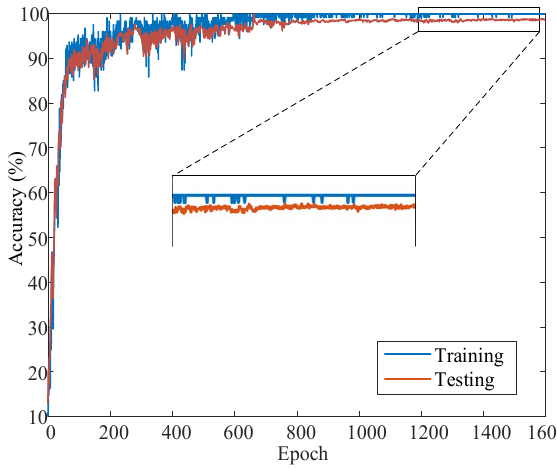
Figure 9. BayesianPDL framework training process. When PFRBs is 3, the uncertainty distribution of the network is shown in Figure 10. The probability density of the uncertainty distribution proposed method is significantly reduced due to the heavily disturbed noise on the signal at low SNR. This reduces the confidence of the diagnostic results and reduces the diagnostic accuracy. At higher SNR, the probability density is highly uniform with higher confidence. As SNR increases, so does the confidence of BayesianPDL, which gives high confidence in the diagnosis. Therefore, when the number of PFRBs is 3, the diagnostic results have the highest confidence and the highest accuracy, thus obtaining the optimal Bayesian PDL.